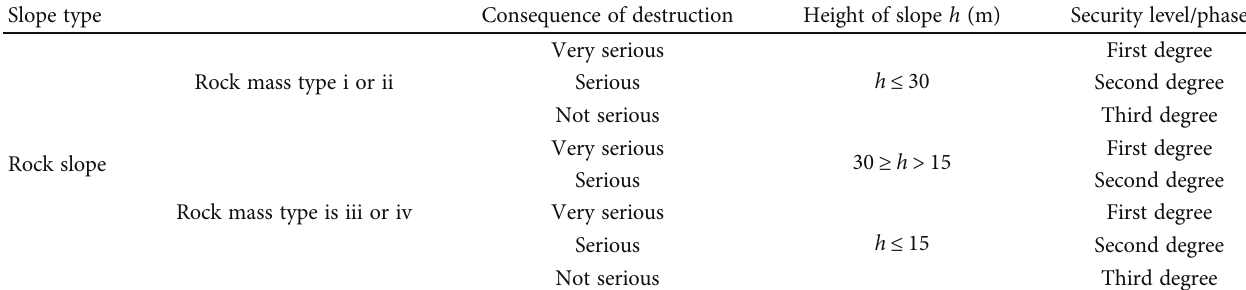
Table 9: Safety grade of slope